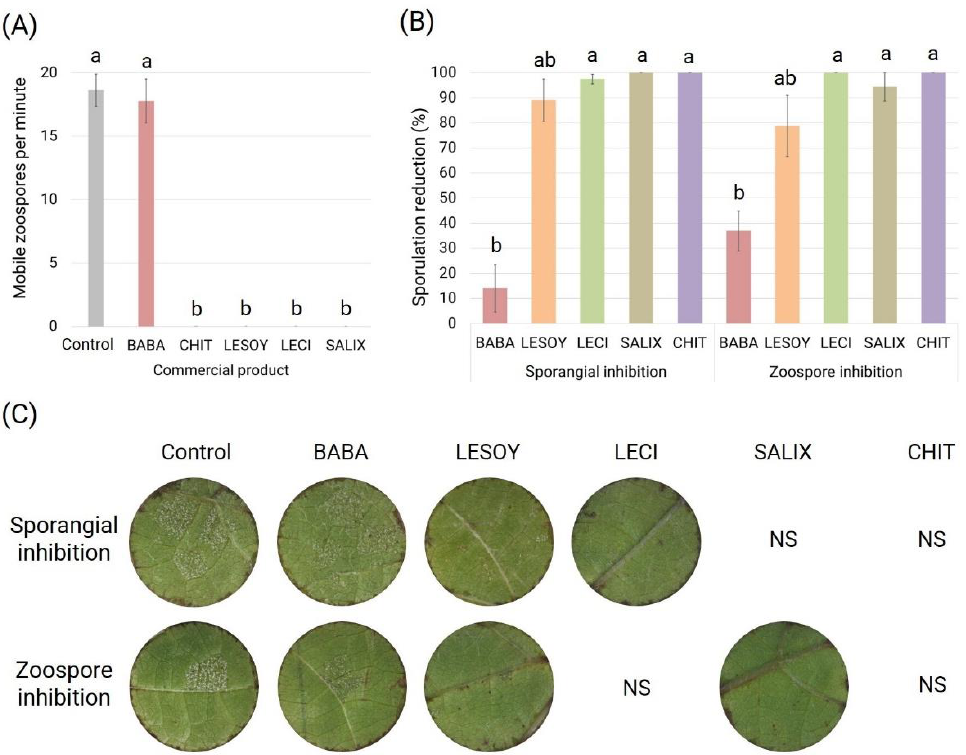
Figure 2. CHIT, LECI, LESOY, and SALIX showed a direct toxicity against P. viticola , both at the sporangial and zoospore level, while BABA did not affect their viability. ( A ) Mobile zoospores per minute observed when mixed with the products at the recommended dose. ( B ) Sporangial and zoospore inhibition by the products as a percentage of reduced sporulation. A Dunn’s post - hoc test (α = 0.05) was performed for both experiments to find significant differences between products, which are denoted by different small letters in the bar graphs. ( C ) Visual evidence of sporulation reduction and toxicity of the selected products on leaf discs seven days after pathogen inoculation. No sporulation (NS).